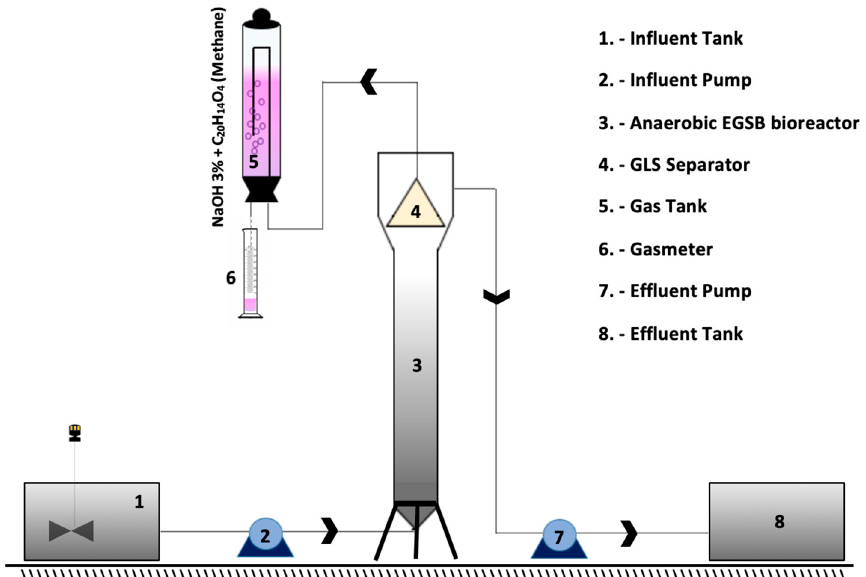
Figure 3. Schematic representation of the treatment system with expanded granular sludge bed (EGSB) bioreactor.